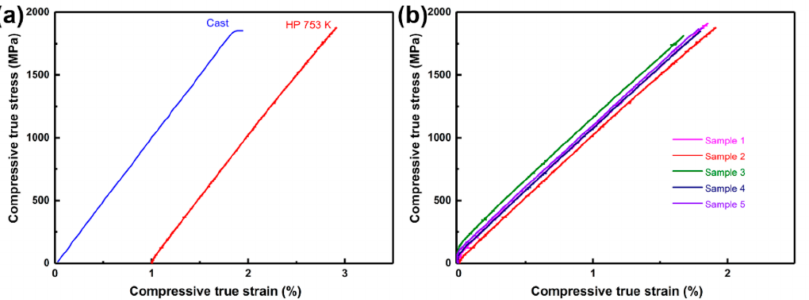
Figure 6. ( a ) Representative room-temperature stress–strain curves under compression for the Zr 48 Cu 36 Al 8 Ag 8 bulk specimen hot pressed at 753 K and the corresponding material synthesized by casting [20]. For clarity, the curve of HP 753 K was offset along the horizontal axis. ( b ) The five compressive stress–strain curves of the Zr 48 Cu 36 Al 8 Ag 8 BMG hot-pressed at 753 K used to derive average strength and corresponding